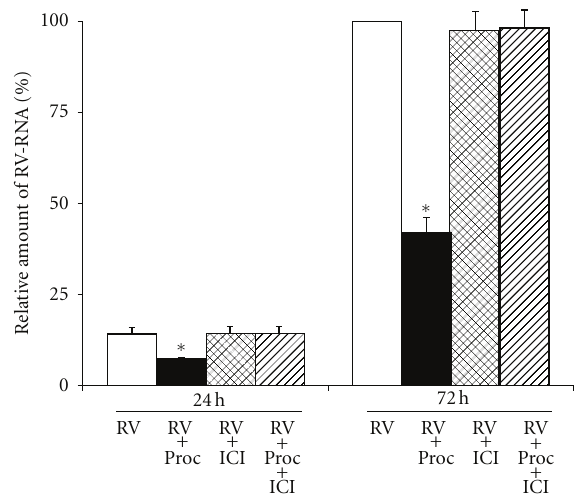
Figure 6: Replication of viral RNA in human tracheal epithelial cells at 1 day (24h) or 3 days (72h) after infection with type 14 rhinovirus in the presence of procaterol (0.1 μ M) (RV + Proc), vehicle (0.01% ethanol) (Control; RV), ICI 118551 (1 μ M) (RV + ICI) or the presence of procaterol (0.1 μ M) plus ICI 118551 (1 μ M) (RV + Proc + ICI) as detected by real-time quantitative RT-PCR. The epithelial cells isolated from the same donors were treated with either procaterol, vehicle, ICI 118551, or procaterol plus ICI 118551. The results are expressed as the relative amount of RNA expression (%) compared with that of maximal rhinovirus RNA at day 3 (72h) in the cells treated with vehicle, and reported as means ± S.E.M. from 5 samples (2 ex-smokers and 3 non-smokers). Significant di ff erences from treatment with a vehicle (RV) at each time are indicated by ∗ P < 0.05. (Cited from